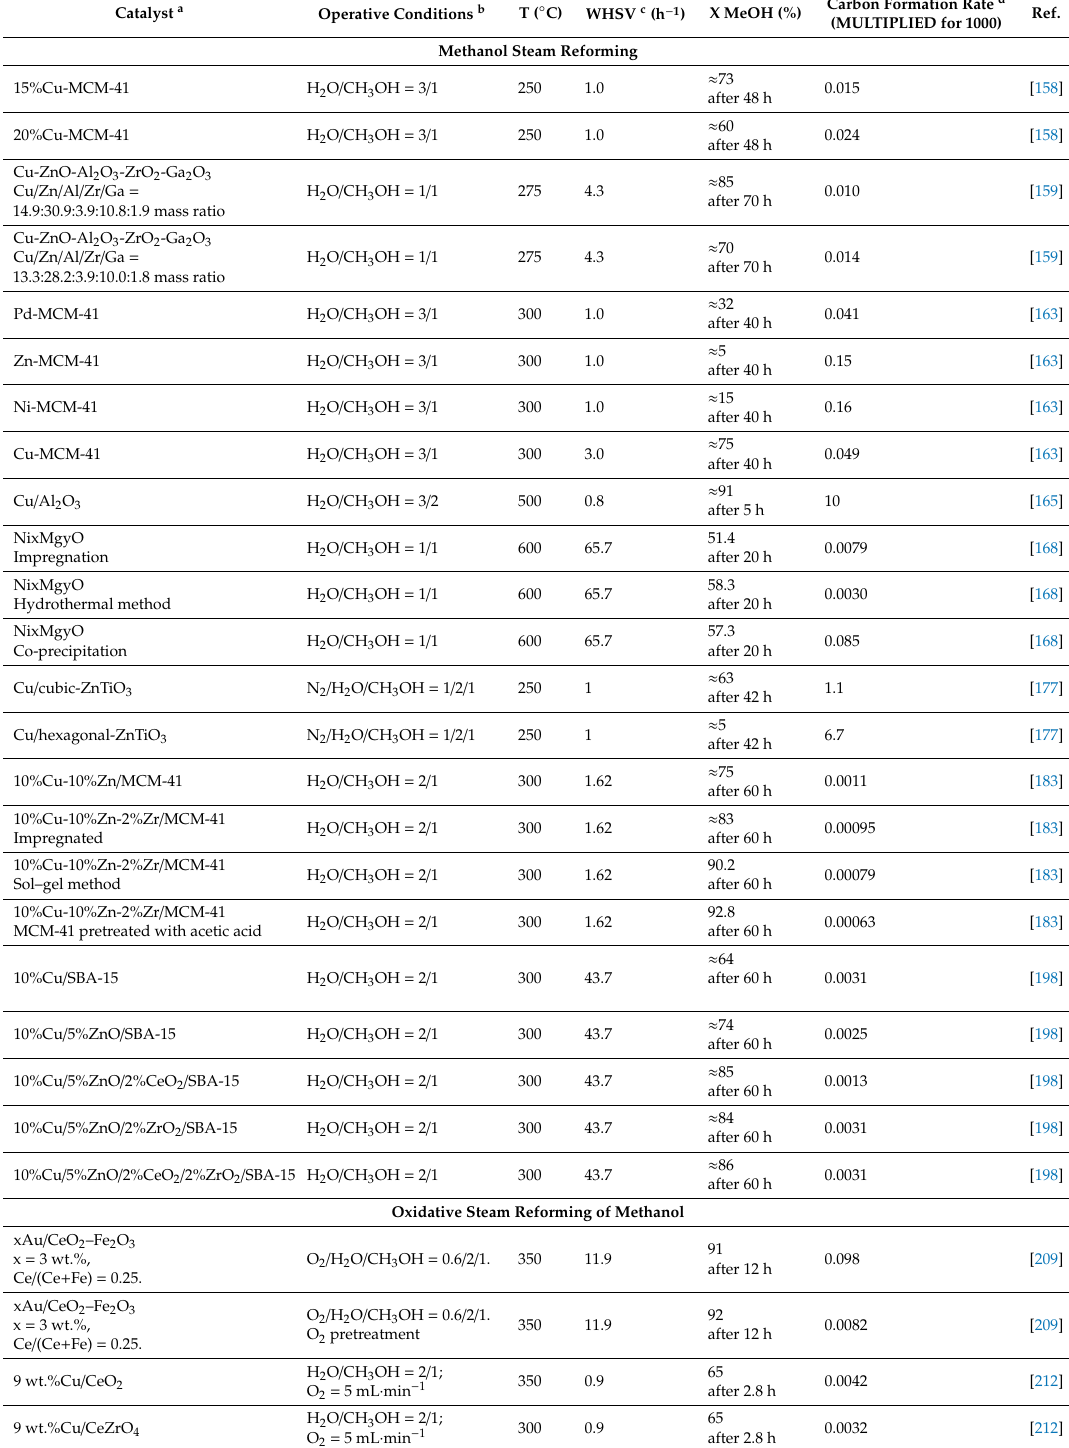
Table 2. Carbon formation rates for various catalysts employed for steam reforming and oxidative steam reforming of